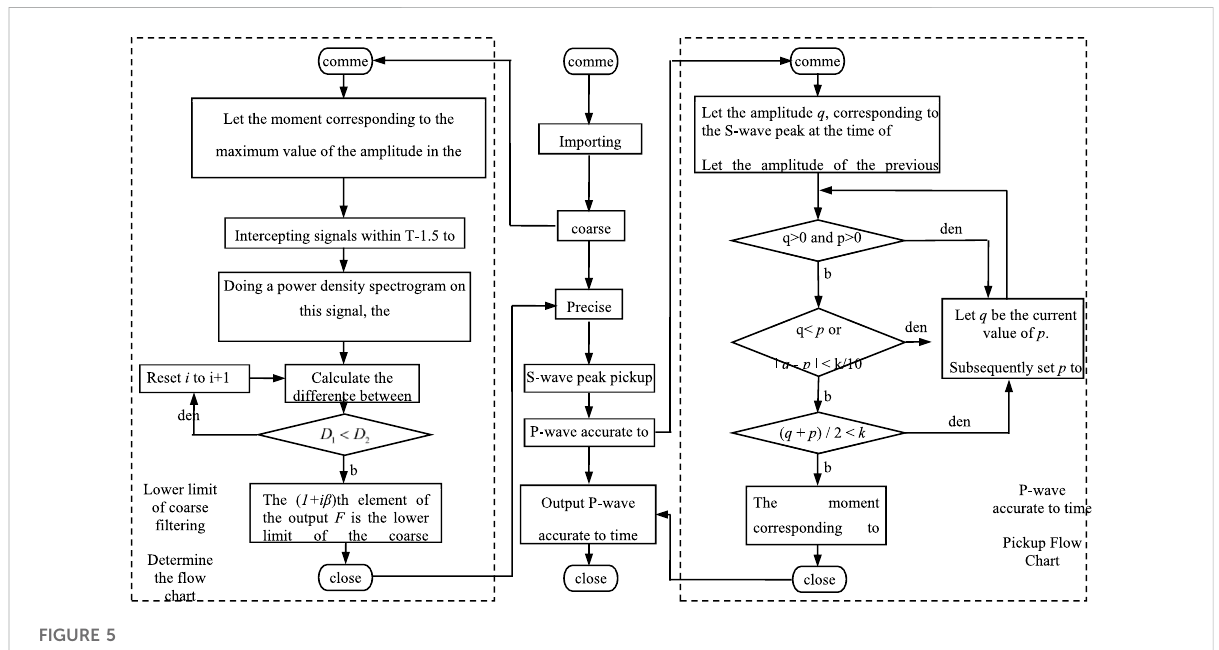
FIGURE 5 Flow chart of the TFA-DC method